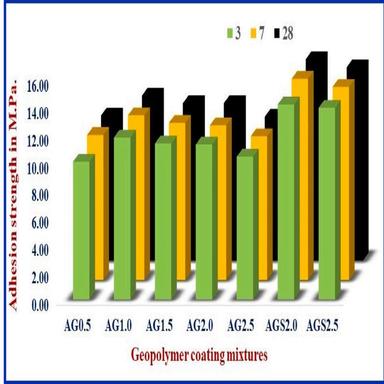
Trends of adhesion strength of geopolymer coating compositions with mild steel for three different curing durations (3, 7, 28 days).